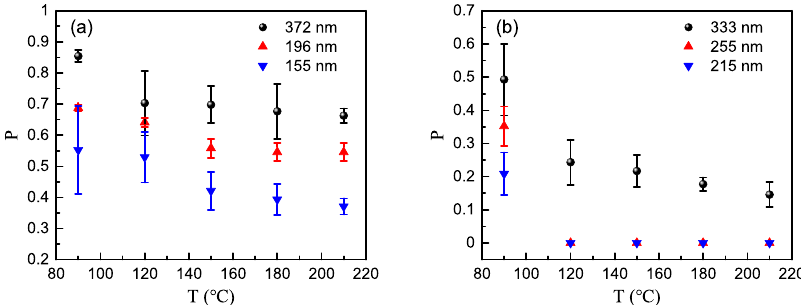
Figure 6. The dependence of the thermal stability parameter, P, on the post-poling annealing temperature T for both stripe domains ( a ) and dot domains ( b ) of various sizes without pre-heat treatment. Here, the post-poling thermal annealing time t was set to be 1 h in all cases, and the length of the stripe domains was set to be ∼ 4 µ